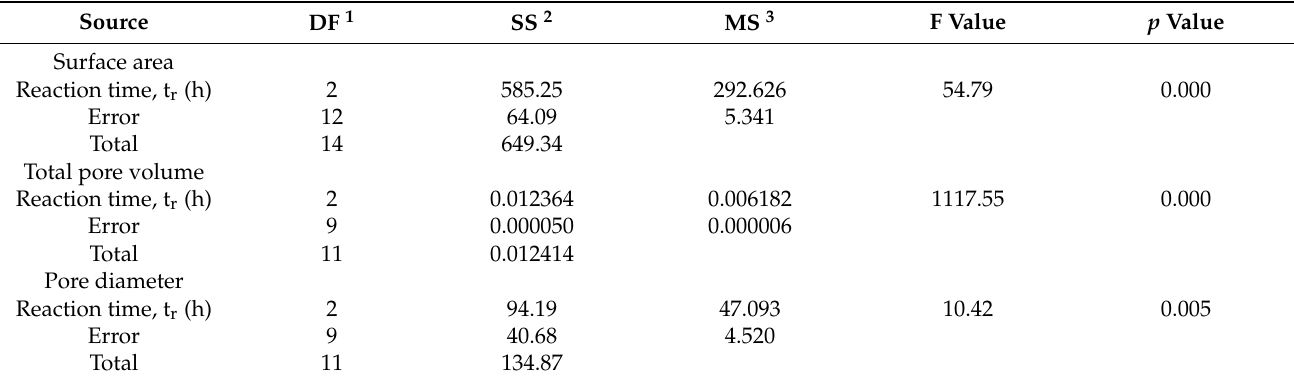
Table 1. Analysis of variance for the surface properties of the nanocomposites.